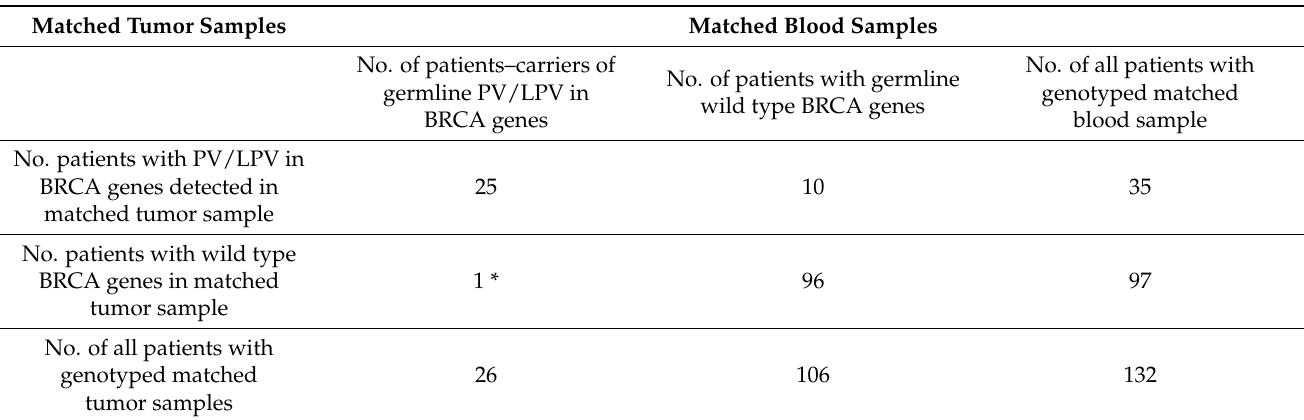
Table 4. Comparison of tumor and germline genotyping results, for germline PV/LPV in BRCA genes, of matched tumor blood samples from the cohort of 132 advanced non-mucinous EOC patients, who had successfully genotyped tumors and blood samples.